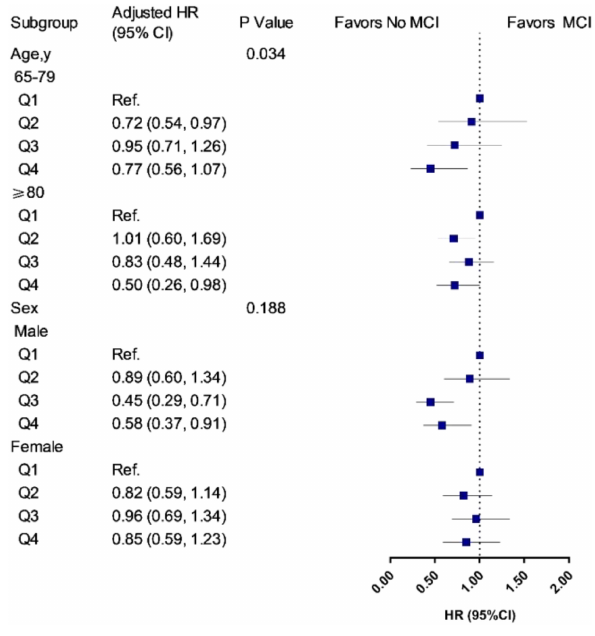
FIGURE 3 | Associations of UA quartiles with the risk of MCI in age and sex subgroups. HR, hazard ratio; CIs, confidence intervals. The model was adjusted for age (not in age subgroup) and sex (not in sex subgroup), education, drinking, smoking, marital status, regular exercise, body mass index, central obesity, adequate medical service, hypertension, diabetes mellitus, self-reported history of heart disease, and stroke/CVD. Q1 was defined as the reference group. In the age subgroup, participants aged 65–79 years, the cutoff values of UA quartiles were 245.4, 291.6, and 355.4 µ mol/L for men, and 195.2, 242.0, and 296.4 µ mol/L for women; participants aged 80 years and older, the cutoff values of UA quartiles were 262.0, 315.0, and 377.1 µ mol/L for men, and 220.0, 270.7, and 329.8 µ mol/L for women. In the sex subgroup, the cutoff values were